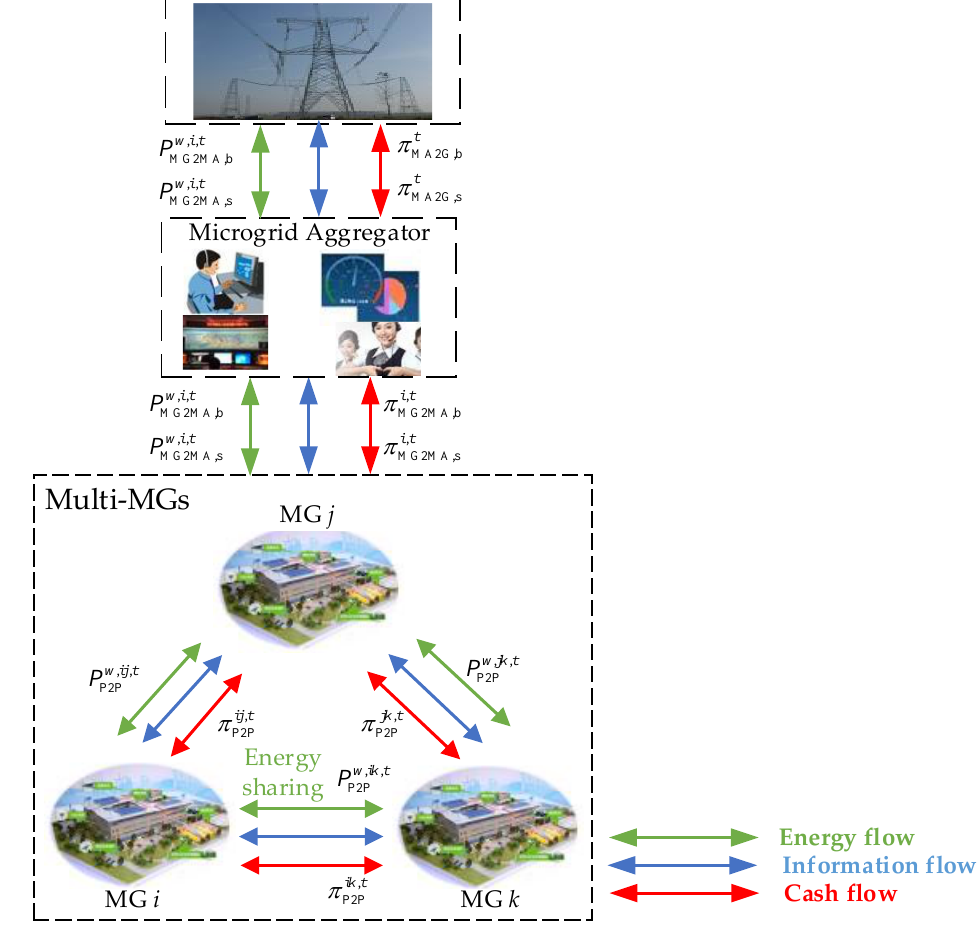
Figure 1. Framework diagram for energy management.